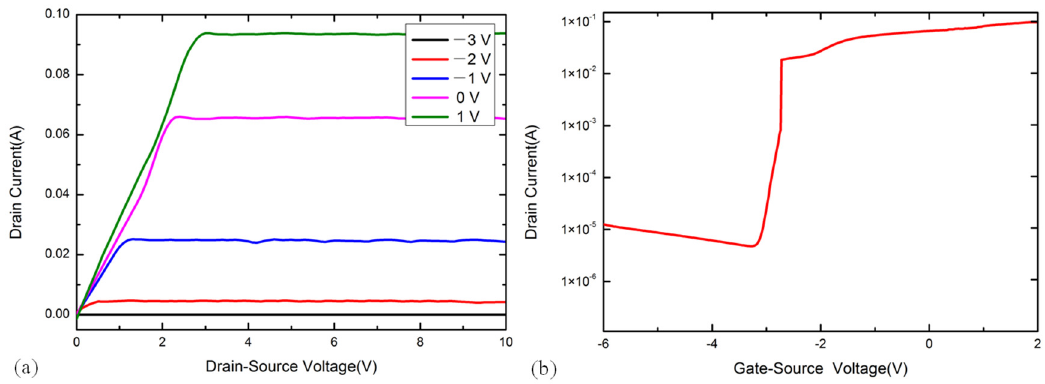
Figure 2. The electrical characteristic of InAs QD-HEMT ( a ) The output characteristic (I DS -V DS ) ( b ) The transfer characteristic.